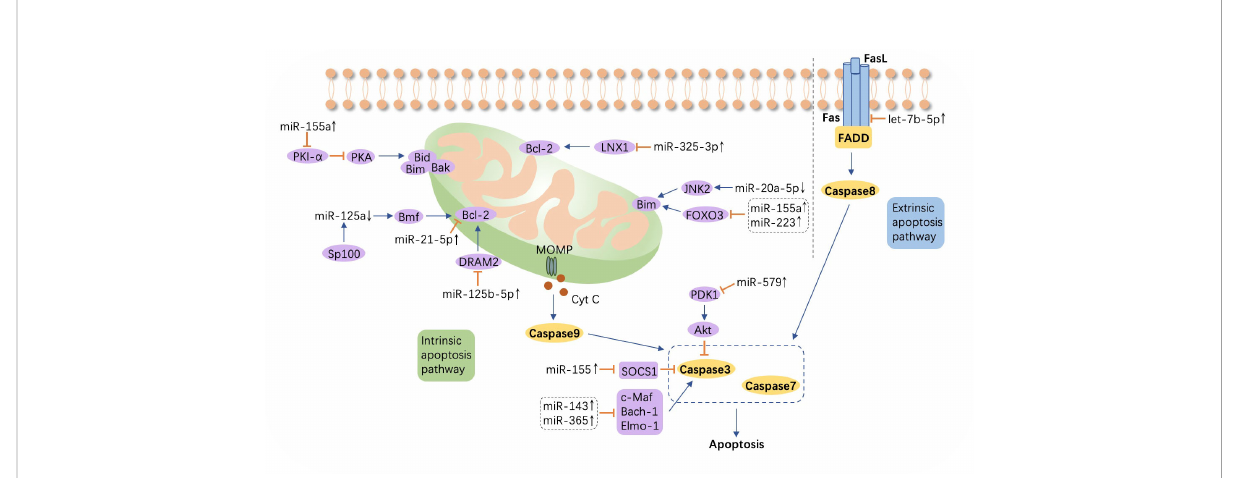
FIGURE 4 A schematic showing apoptosis and relevant microRNAs during Mycobacterium tuberculosis infection. Extrinsic apoptosis is activated by the combination of Fas and FasL, with the engagement of Fas-associated protein with DD (FADD) and the subsequent activation of caspase 8. In intrinsic apoptosis, cytochrome c (Cyt c ) is released into the cytosol from mitochondria through mitochondrial outer membrane permeability (MOMP), which process is regulated by the Bcl-2 family. Altered microRNAs (miRNAs) target the Bcl-2 family or other molecules such as ligand of numb-protein X1 (LNX1), Forkhead box transcription factor class O (FOXO), DNA damage regulated autophagy modulator 2 (DRAM2), suppressor of cytokine signaling (SOCS), c-Maf, BTB and CNC homology 1 (Bach-1), and Engulfment and cell motility protein 1 (Elmo-1). ↑ , upregulated; ↓ , downregulated; ⟶ , stimulate; ⟞ ,